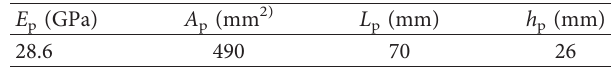
Table 2: Parameters of the piezoelectric actuator and acting